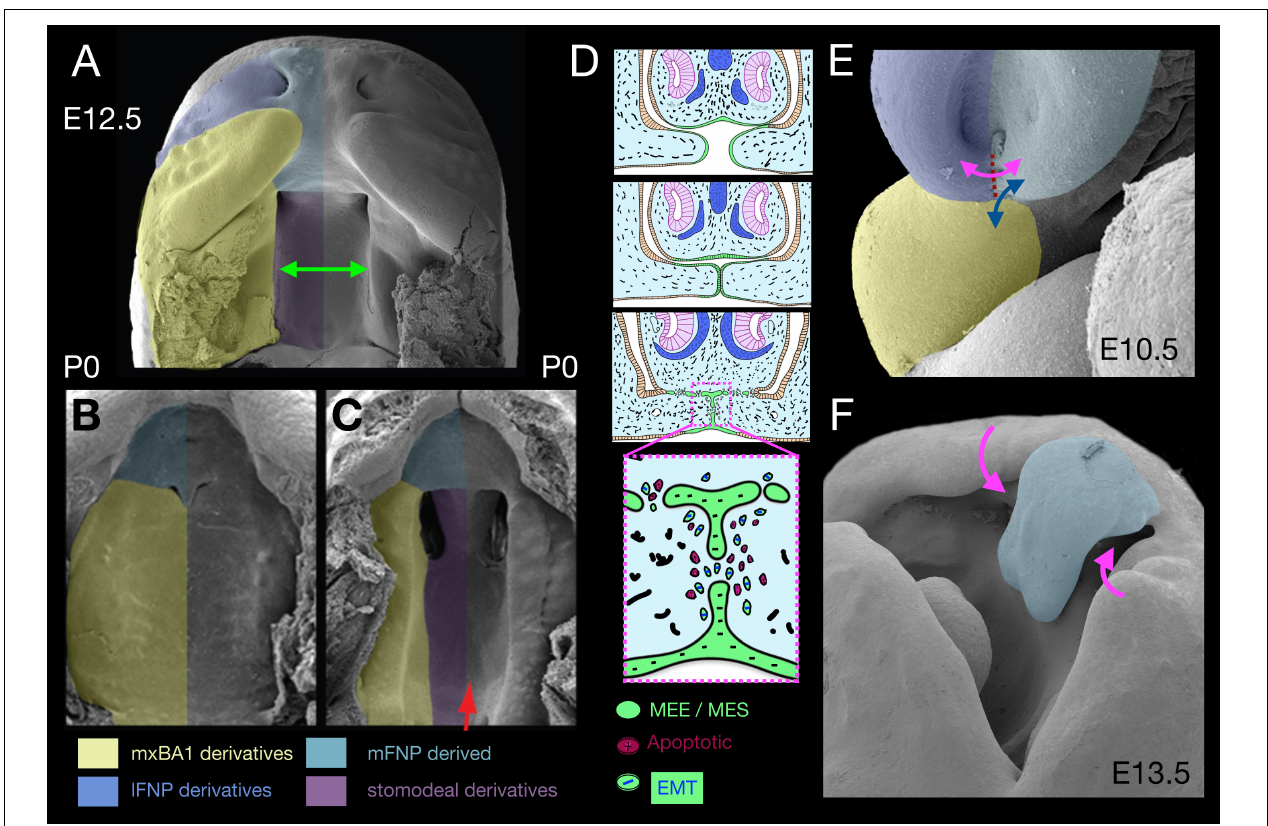
FIGURE 2 | Apical-apical epithelial apposition, orofacial clefting, and apoptosis. (A–C) Pseudocoloured scanning electron micrographs of the secondary palate at E12.5 ( A , green arrow) and P0 (B) . The secondary palate in panel (C) is cleft due to a deficiency of Gas1 . (D) Schema of the apposition of nasal septum and secondary palatal shelves wherein apoptosis acts in conjunction with epithelial-mesenchymal transition (EMT) and migration to remove the MEE/MES. (E) λ in an E10.5 mouse embryo. Dotted red line, topography of nasal fin. Double headed arrows indicate significant appositions. magenta, nasal fin; blue, mxBA1-mFNP. (F) E13.5 mouse embryo evincing a cleft lip and cleft primary palate (magenta arrows). Blue psuedocolour indicates the mFNP